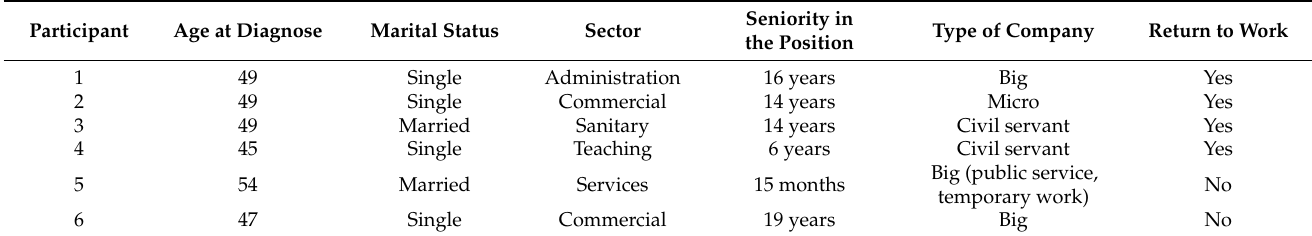
Table 2. Description of the main socio-occupational characteristics of the female workers in the focus group.